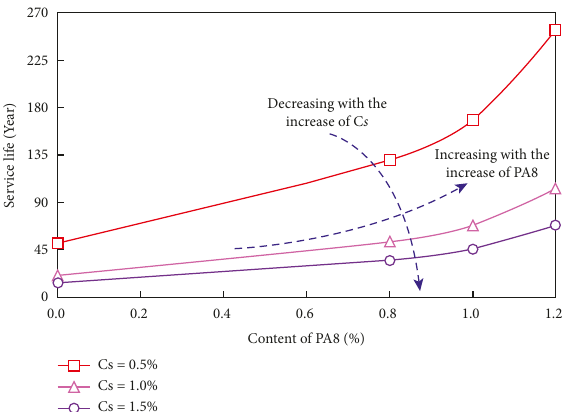
Figure 8: Calculation results for the service life of concrete structures with different PA8 and C